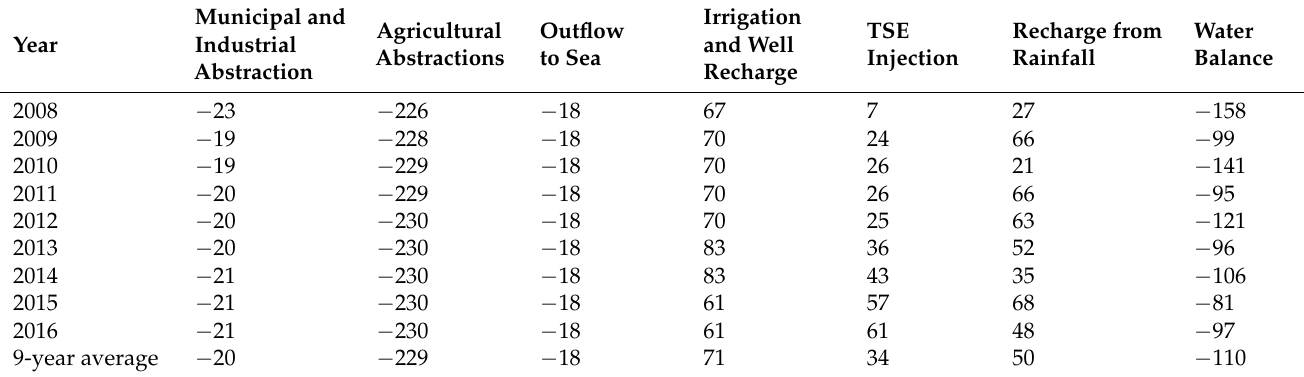
Table 2. Water balance components (million m 3 ) of Qatar